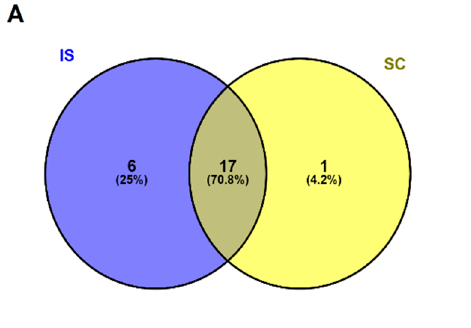
Figure 3. Venn diagram of shared and unique OTUs in the gut profile of river and weir midges. OTUs were clustered using a threshold distance of 0.03. ( A ). Further, 17 common taxa in IS and SC were Arthropoda, Ascomycota, Basidiomycota, Cercozoa, Chlorophyta, Ciliophora, Diatomea, Dinoflagellata, Euglenozoa, Heterolobosea, Nematozoa, Nucleariidae/Fonticula, Ochrophyta, Peronosporomycetes, Phragmoplastophyta, Rotifera and Vertebrata. 6 unique food sources of IS midges were Annelida, Chytridiomycota, Cryptophyta, Marine Stramenophiles, Mollusca, and Haptophyta and a rare group in SC is Cryptomycota. ( B ). 12 common food content in IP, SJ, JS, and GG were Ascomycota, Basidiomycota, Cercozoa, Chlorophyta, Chytridiomycota, Cryptomycota, Diatomea, Euglenozoa, Ochrophyta, Peronosporomycetes, Phragmoplastophyta, and Vertebrata. OTUs of Arthropoda were shared between IP, SJ, and JS. Rotifera was the shared food item in SJ, JS, and GG. Protalveolata was a common taxon in SJ and GG, Halobacterota in IP and JS, Ciliophora, Cnidaria, and Nucleariidae/Fonticula were the common diet components in JS and GG. Heterolobosea (IP), Annelida (SJ), Euryarchaeota, and Amoebozoa (JS) were the unique food items shown.